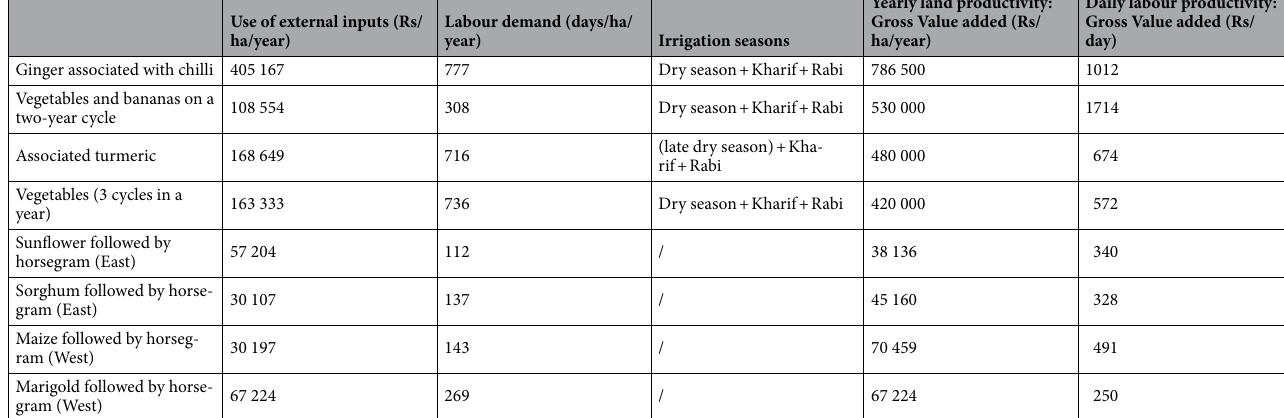
Table 1. Comparison of cropping systems: use of external inputs, labour demand and productivities. Prices are in Indian Rupees (Rs). Exchange rate with US Dollar (USD) was 1 USD = 67.5